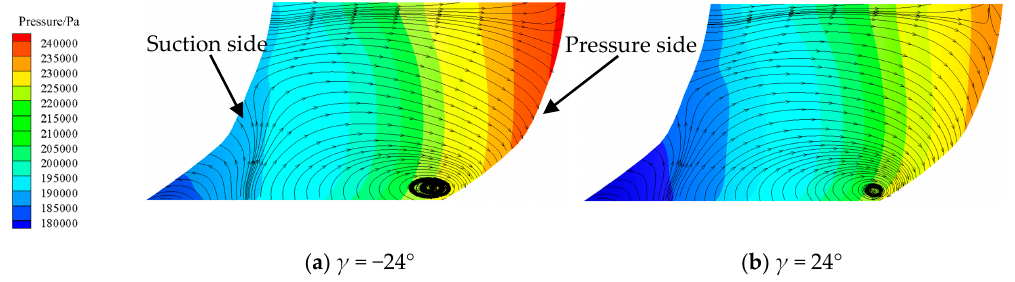
Figure 6. Pressure distribution and surface streamlines in a blade-to-blade passage at Q = 200 m 3 /h.